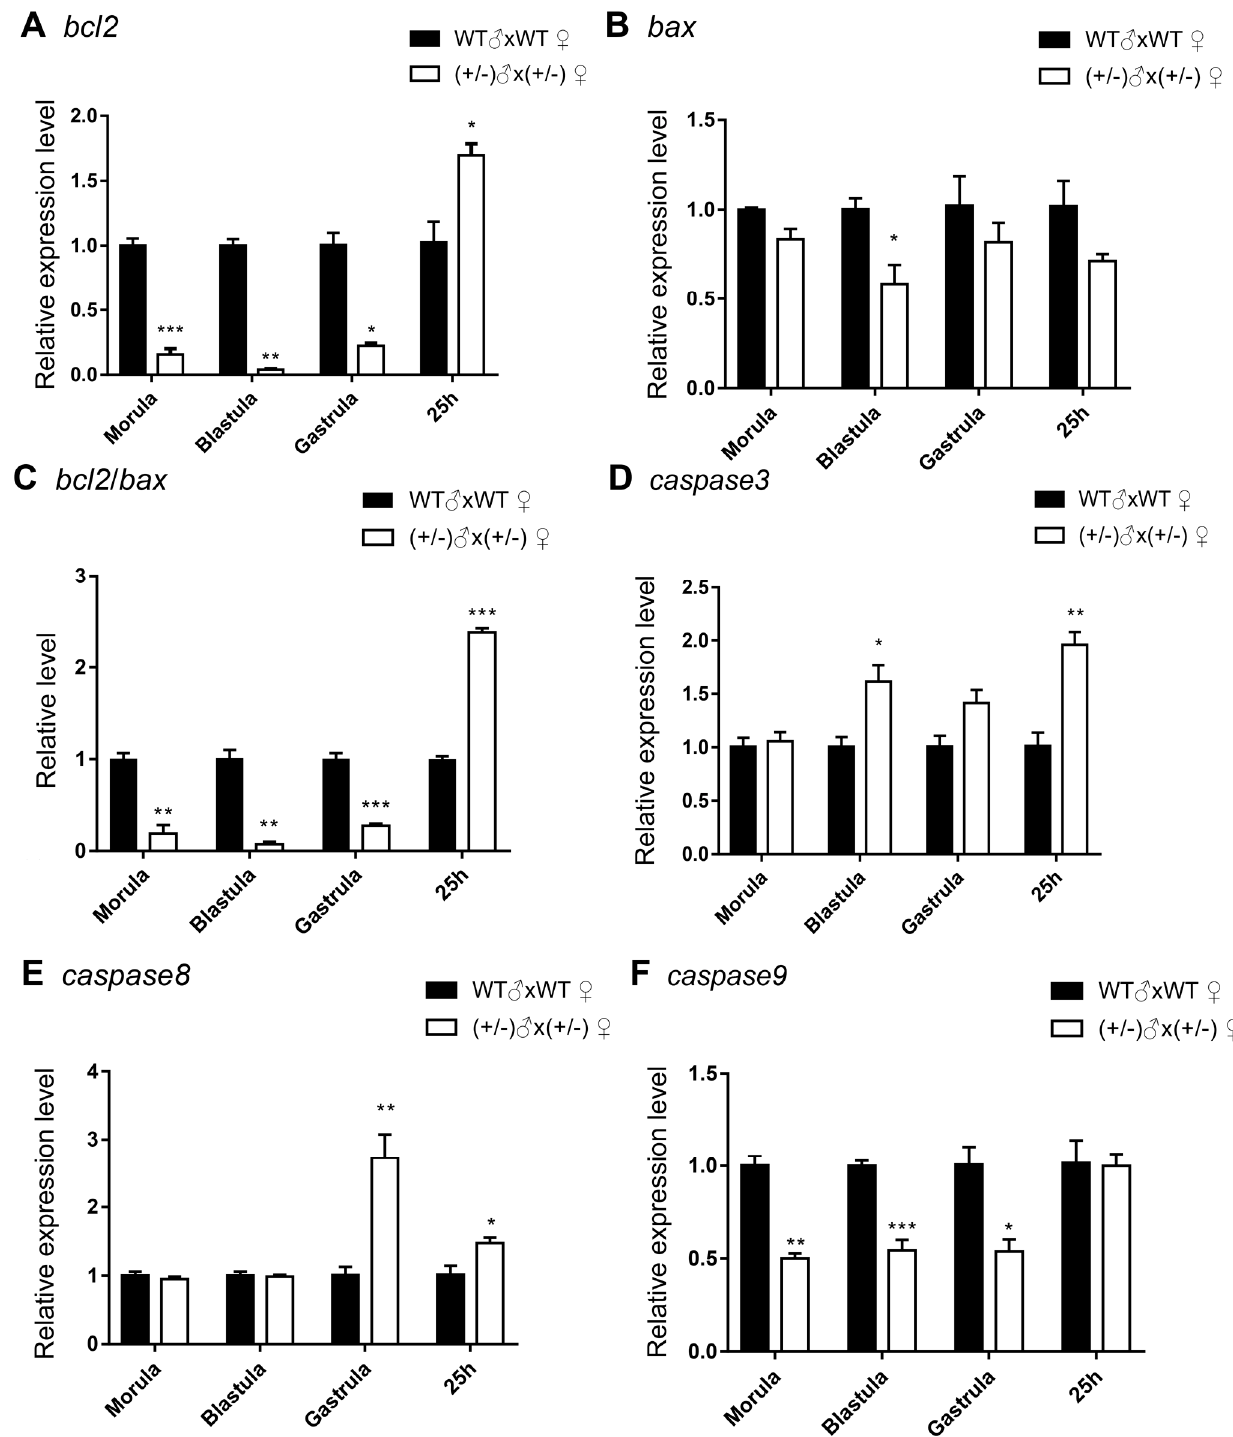
Figure 5. The relative expression of bcl2 ( A ), bax ( B ), caspase3 ( D ), caspase8 ( E ), and caspase9 ( F ), and the ratio of bcl2 / bax ( C ) in the embryos from the morula stage to 25 hpf. The expression of each gene in control was set as 1 at the same stage. The asterisks show the significances. *, p < 0.05; **, p < 0.01; ***, p <